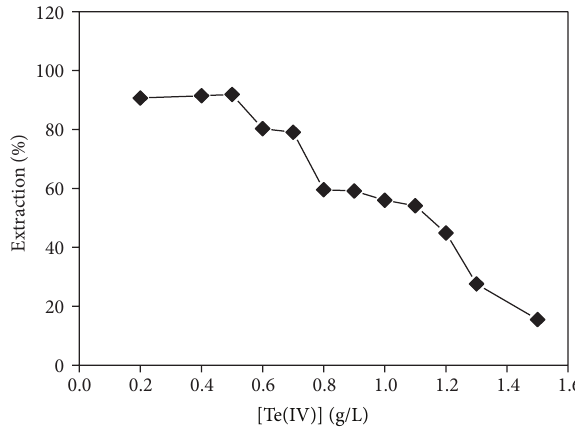
Figure 5: Effect of the initial concentrations of Te(IV) on extraction.